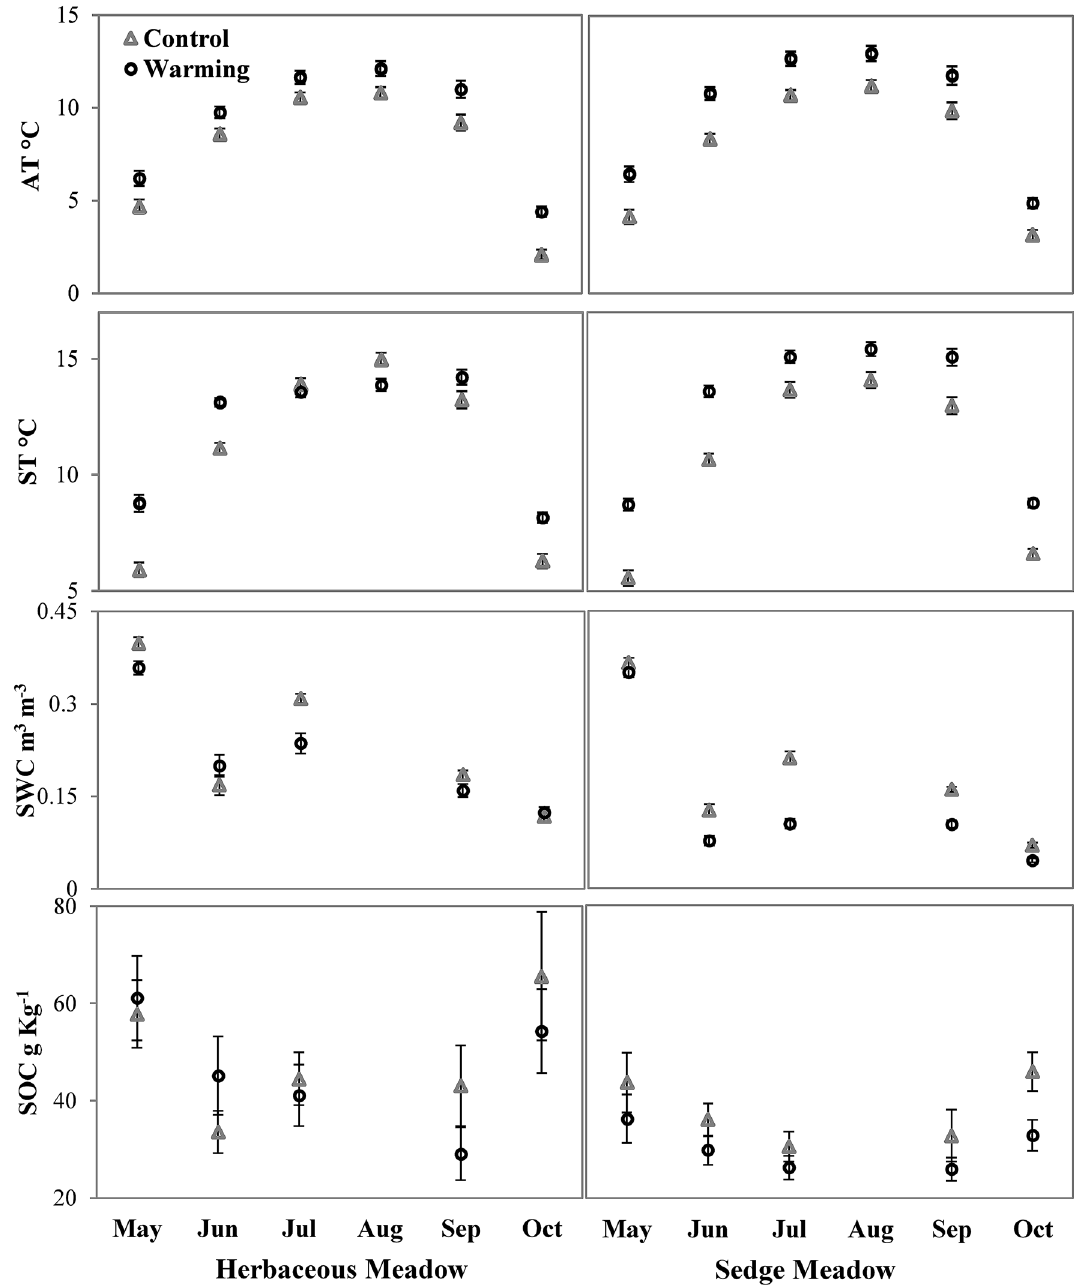
Figure 1. Warming effect on air temperature (AT), soil temperature (ST), volumetric soil water content (SWC) and soil organic carbon (SOC) at Herbaceous and Sedge Meadows. Data show mean ±